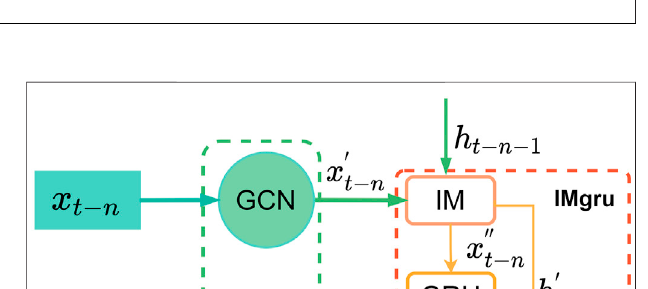
FIGURE 6 | Graph convolutional network structure.